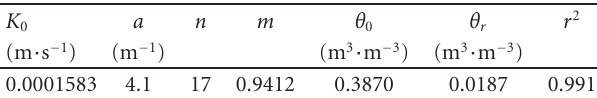
Table 1: Saturated hydraulic conductivity K 0 and parameters a , n , m , q 0 , and q r of the van Genuchten [6] model for the wetting water retention curve of the marine sand and the coe ffi cient of determination r 2